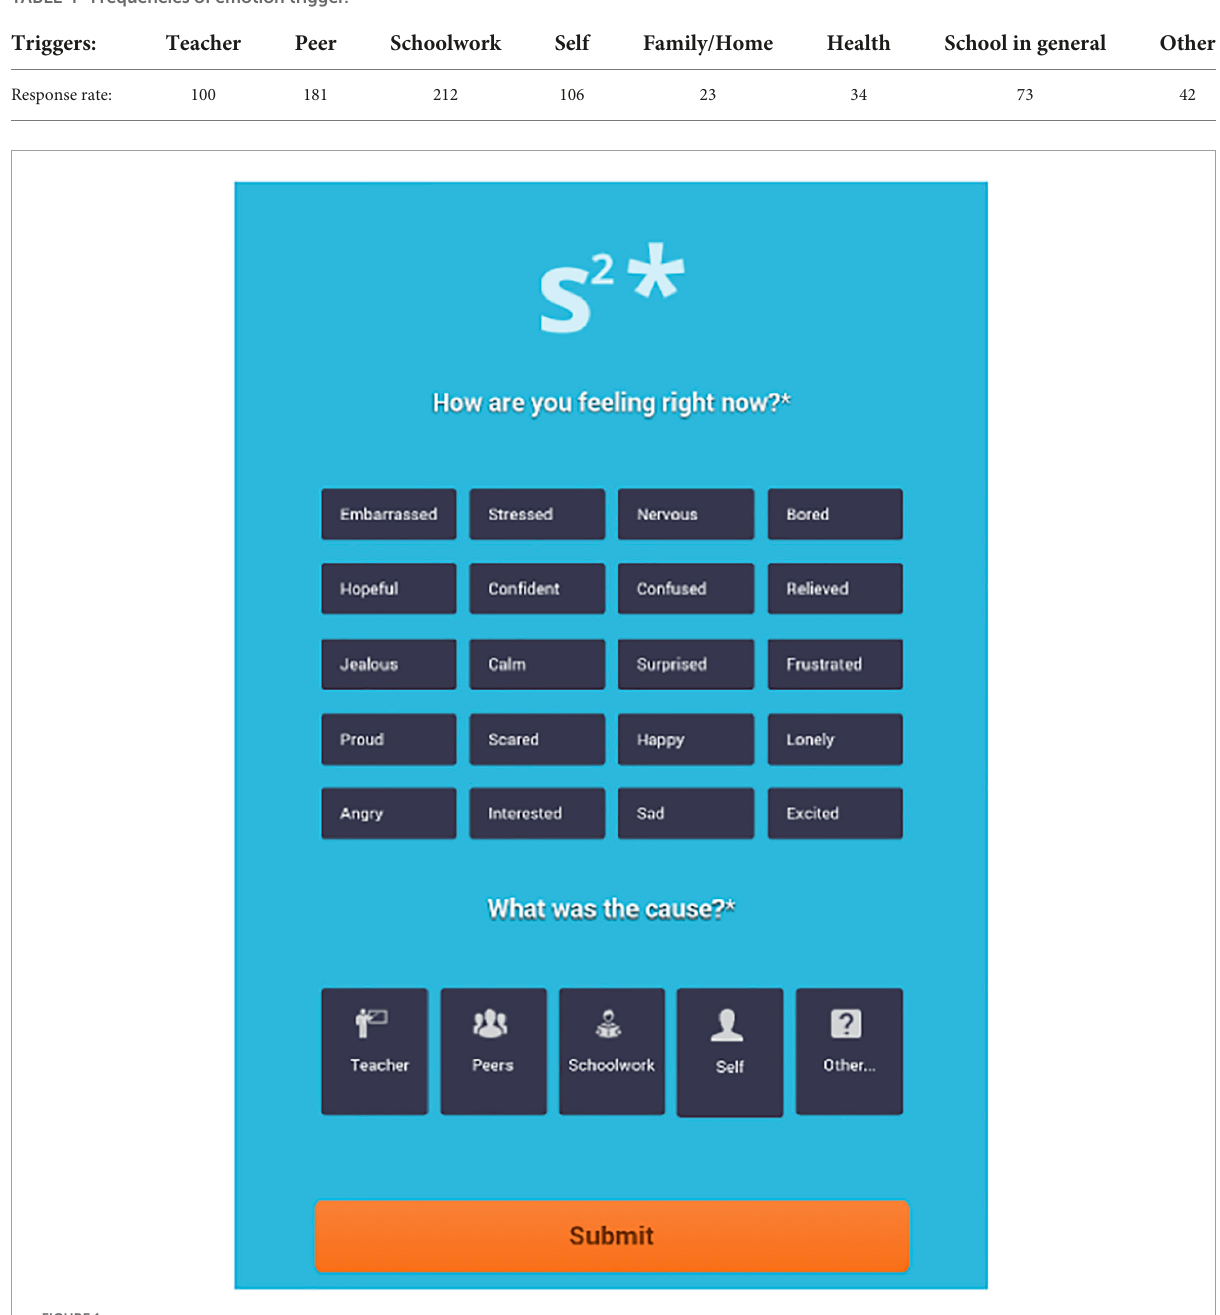
TABLE 4 Frequencies of emotion trigger.